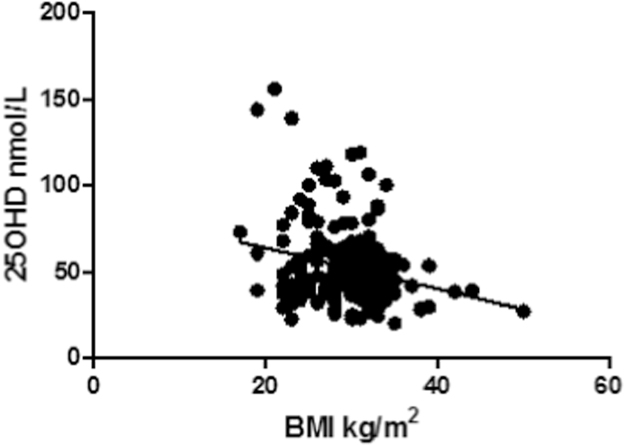
Correlation of patients’ body mass index (BMI) with 25OHD serum concentrations for 210 healthy adults (BMI mean =29.6 kg/m2±4.4; slope =−1.19; 95% confidence interval: −1.84 to −0.53; p=0.0005, r2=0.06).